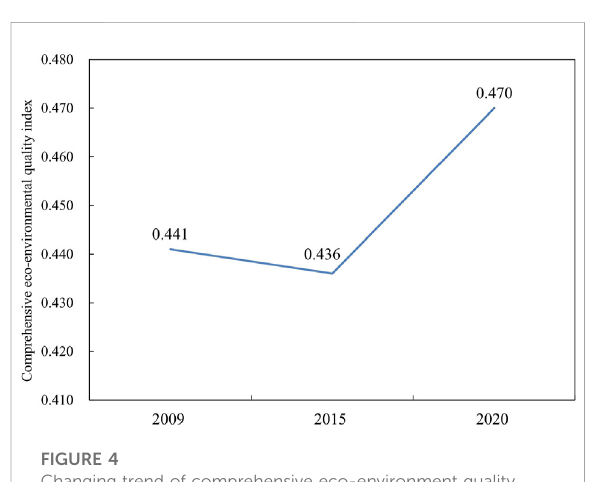
FIGURE 4 Changing trend of comprehensive eco-environment quality index.